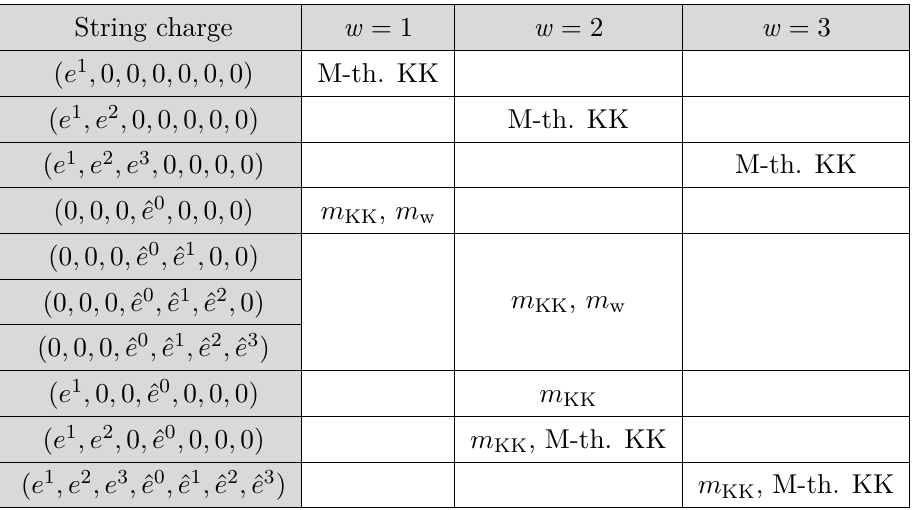
Table 6 . Behavior and identification of m ∗ in comparison with the string tension for some choices of string charges. We have collected ( e , ˆ e ) with the components e a , ˆ e α ∈ Z > 0 . Strings with charge e drive a flow within the Kähler moduli sector; strings with charges ˆ e trigger a flow involving the dilaton and the complex structure moduli. The scalings are invariant for permutations of NS5 string charges e a or D4 string charges ˆ e α . It can be checked that other mixed linear combinations of e and ˆ e do not deliver scaling weights w > 3